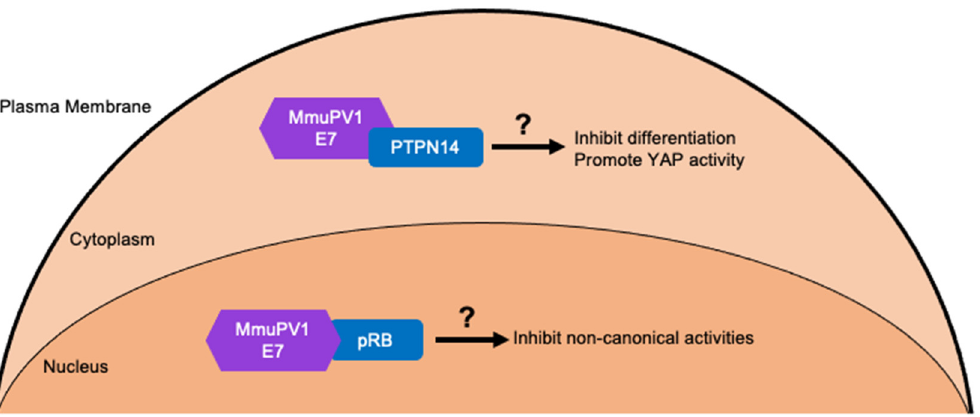
Figure 4. MmuPV1 E7 cellular targets and predicted outcomes. MmuPV1 E7 has been shown to interact with the tumor suppressor pRB [182]. However, the activities of pRB that are affected by this interaction remain unknown. The prediction is that MmuPV1 E7 likely affects non-canonical activities of pRB which are activities not associated with cell cycle regulation since MmuPV1 E7 does not increase E2F activity. Through affinity purified/ mass spectrometry analysis several other cellular targets of MmuPV1 E7 have been identified including the cellular non-receptor tyrosine phosphatase PTPN14 which is a common target of HPV E7 proteins [182]. MmuPV1 E7 ′ s interaction with PTPN14 may inhibit keratinocyte differentiation and/or promote basal cell identity by increasing YAP activity. This is predicted from studies with high-risk HPV E7 proteins that bind and destabilize PTPN14 [78,79].